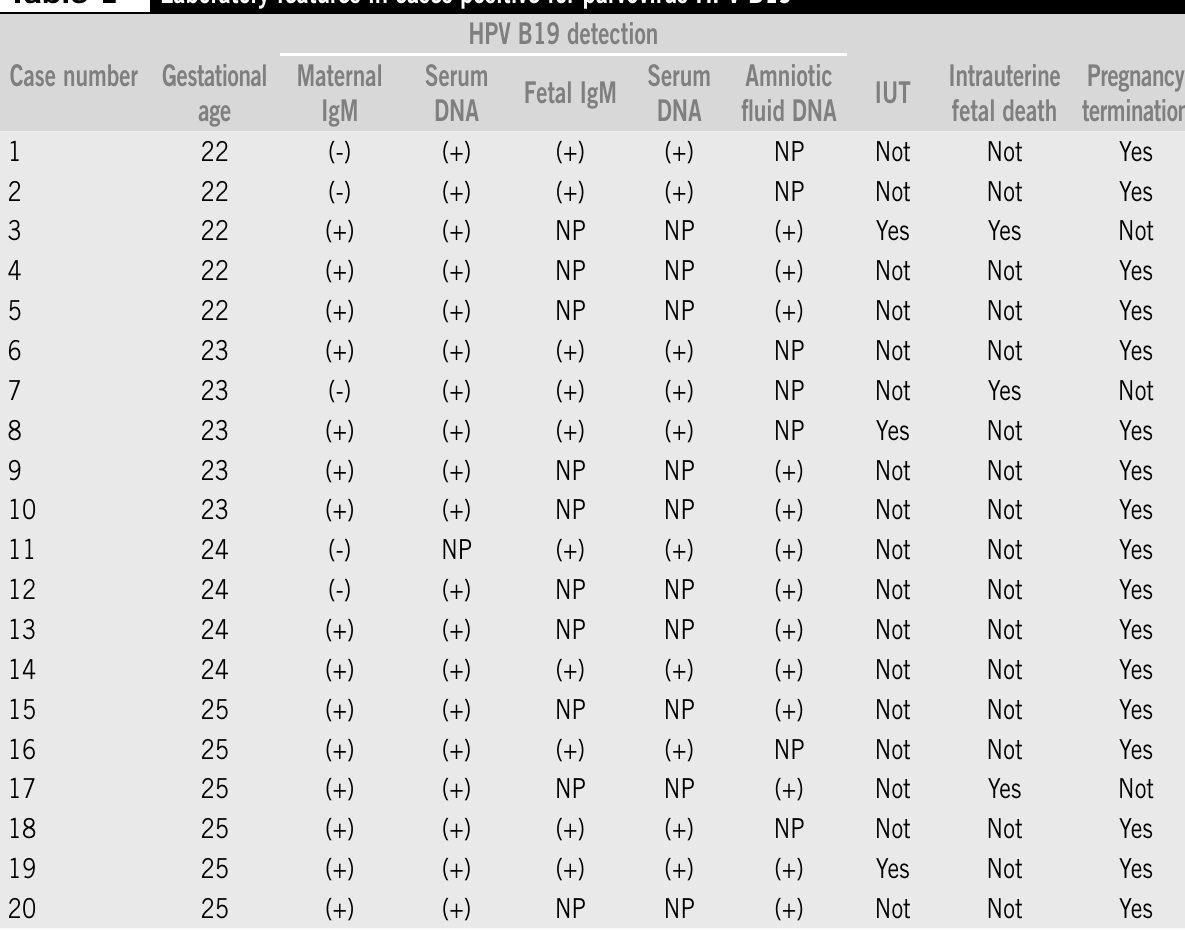
Laboratory features in cases positive for parvovirus HPV B19 HPV B19 detection Case number Gestational